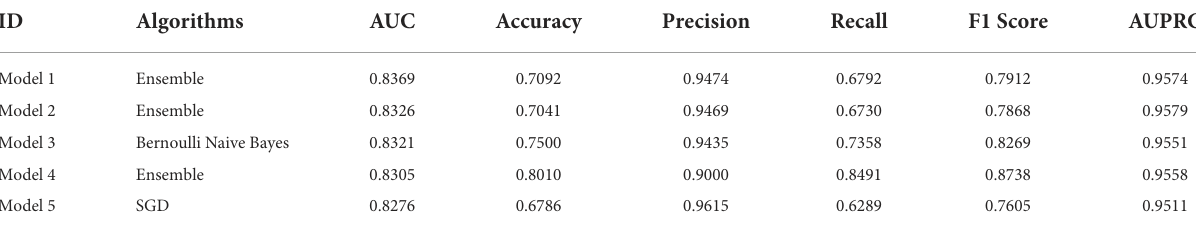
TABLE 3 The summary of the performance of five best